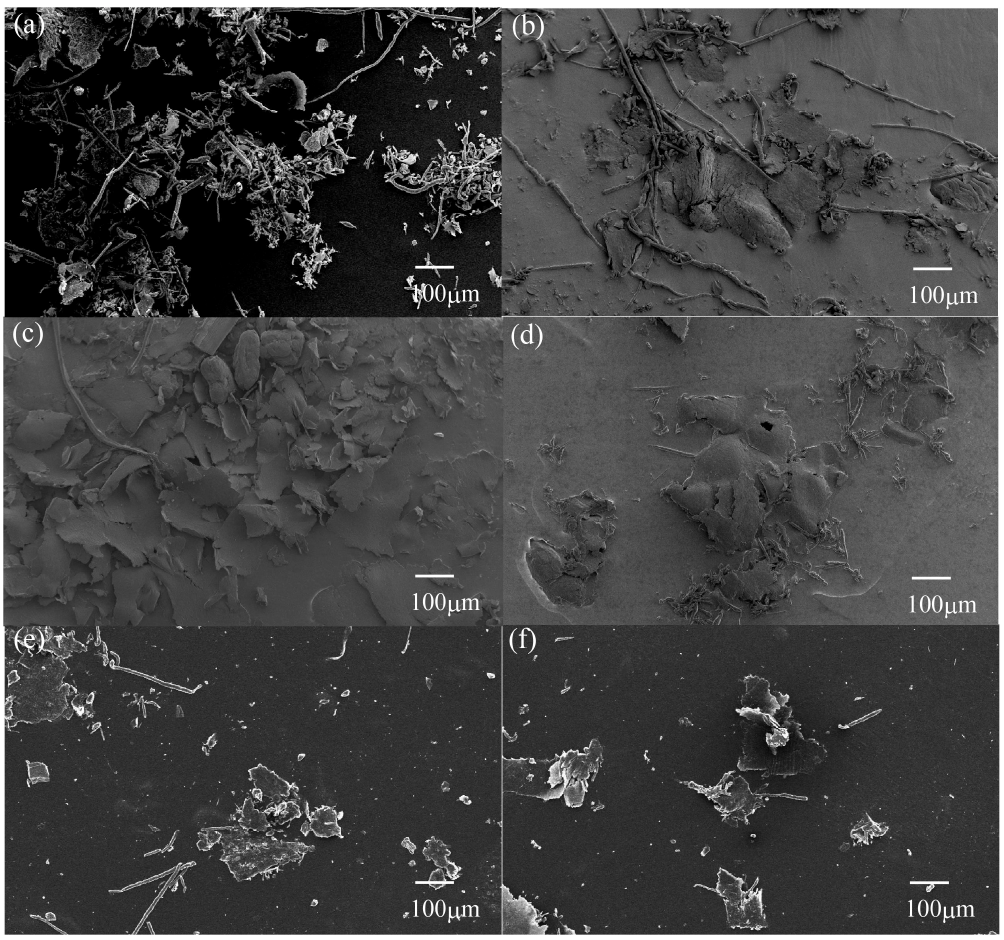
Figure 6. SEM photographs of wear debris after sliding wear tests of various surface-treated HF/PA1010 biomass composites: ( a ) PA1010; ( b ) HF; ( c ) HF-S1; ( d ) HF-S2; ( e ) HF-S3-20 and ( f ) HF-S3-30.